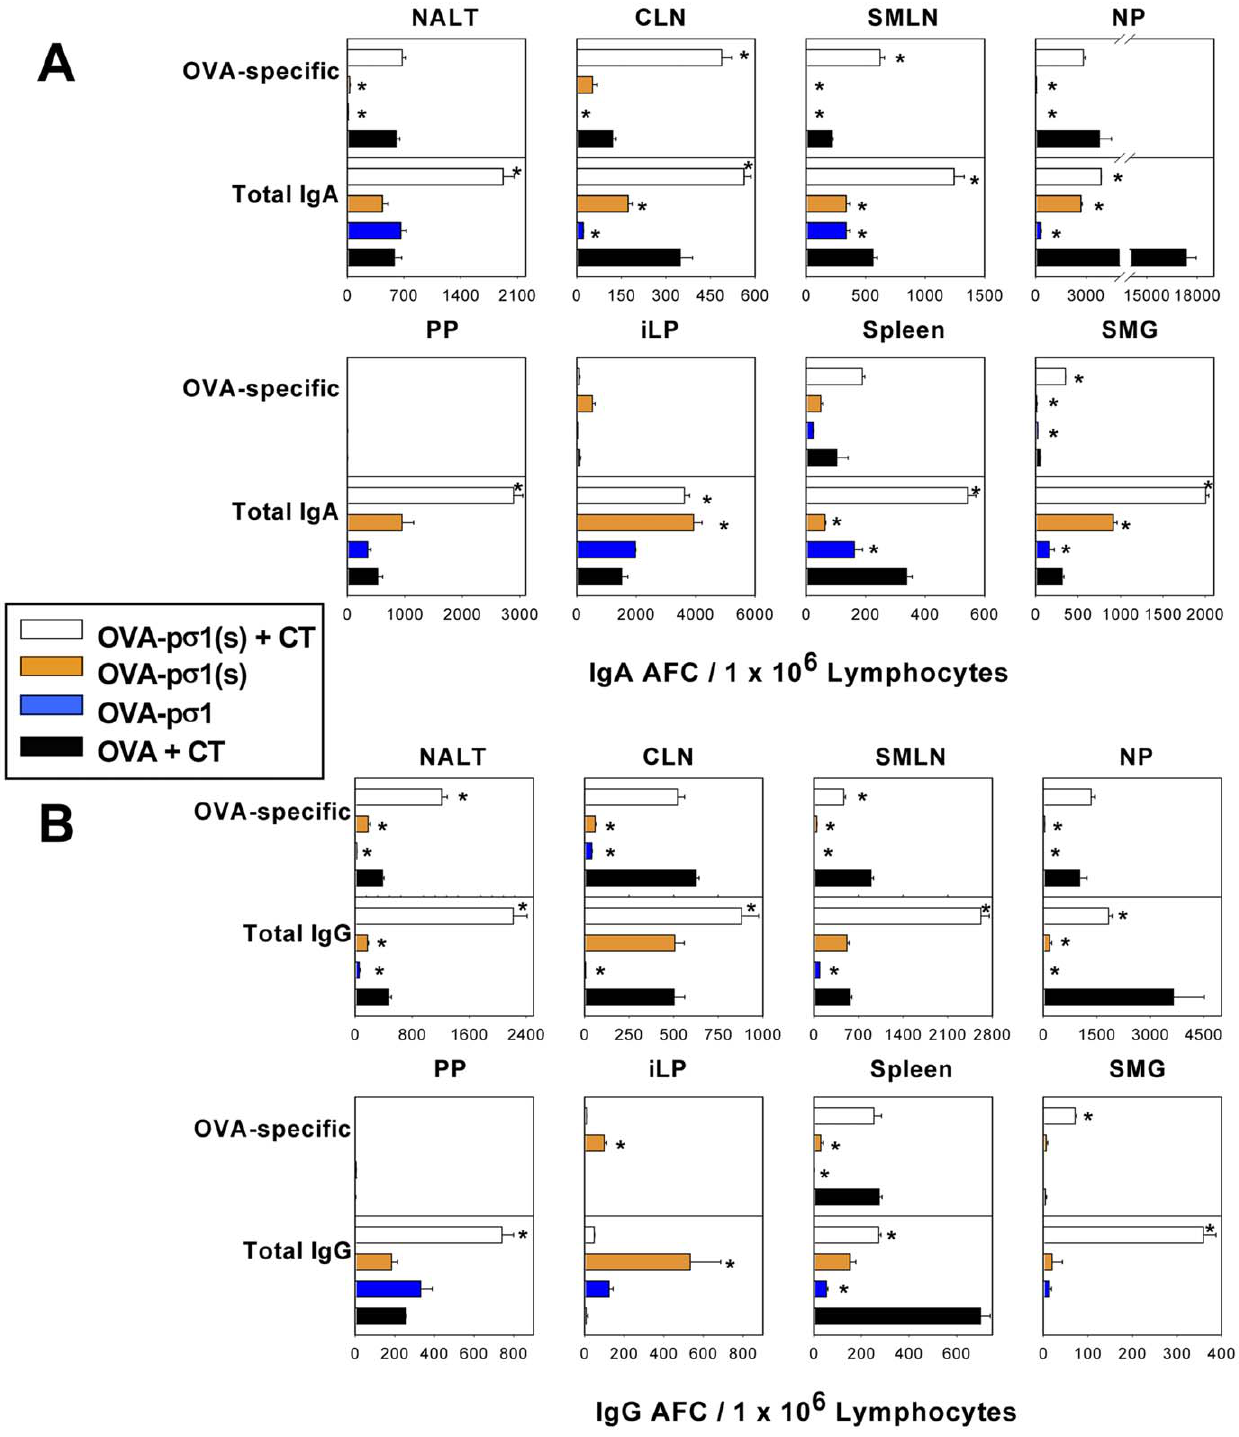
Figure 7. Nasal OVA-p s 1(s) + cholera toxin (CT) enhances A. IgA and B. IgG antibody-forming cell (AFC) responses. C57BL/6 mice were nasally immunized with OVA-p s 1(s) alone, OVA-p s 1alone, OVA-p s 1(s) plus CT, or OVA plus CT. OVA-specific and total A. IgA and B. IgG AFCs were measured by B cell ELISPOT conducted on day 21 post-primary immunization, and NALT, CLNs, SMLNs, nasal passages (NPs), PPs, small intestinal lamina propria (iLP), spleens, and SMGs were evaluated. OVA-p s 1(s) plus CT-immunized mice showed enhanced AFC responses in their CLNs, submaxillary LNs (SMLNs), and submaxillary glands (SMGs) when compared to OVA plus CT-immunized mice. Values are the mean 6 SEM of AFC responses taken from two experiments, * P # 0.001, ** P # 0.01 vs. OVA plus CT-immunized mice.